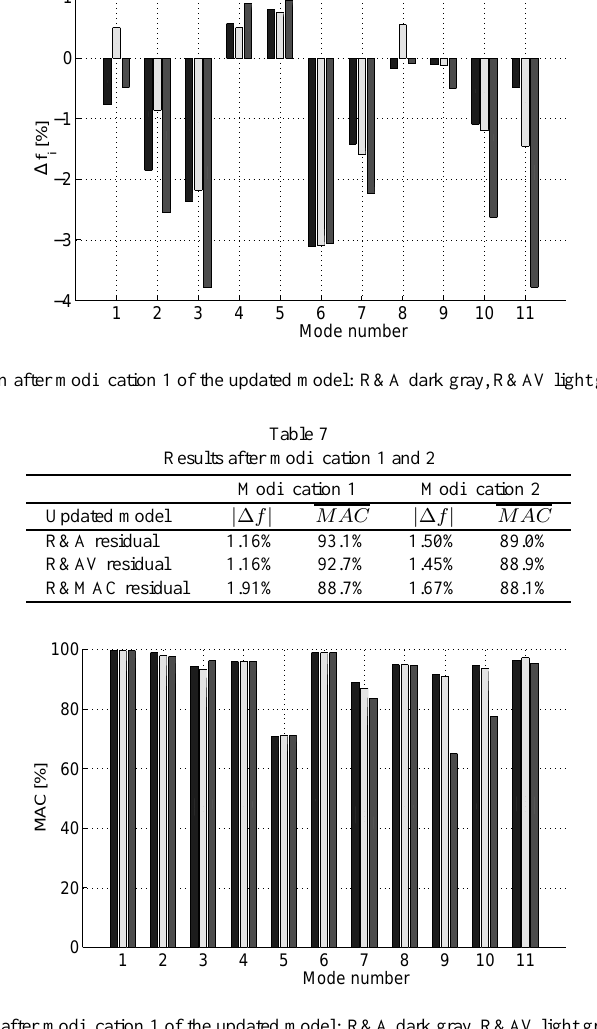
Fig. 12. Mode correlation after modification 1 of the updated model: R&A dark gray, R&AV light gray, R&MAC medium